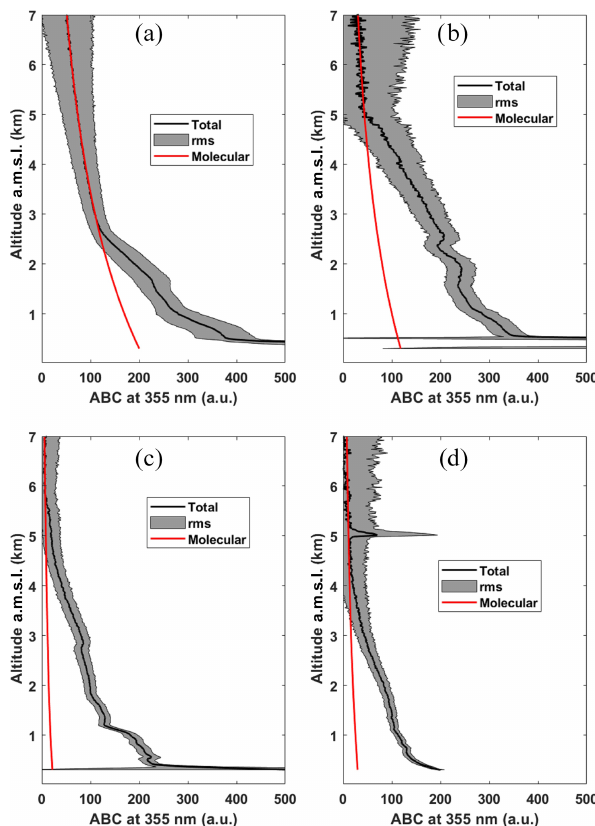
Figure A2. Apparent backscatter coefficient (solid black lines) pro- files obtained from the ALS lidar in Henties Bay on (a) 22 Au- gust 2017 between 14:00 and 23:00UTC, (b) 28 August 2017 be- tween 10:30 and 12:30UTC, (c) 7 September 2017 between 16:00 and 19:00UTC, and (d) 8 September 2017 between 13:00 and 15:00UTC. The red lines correspond to the molecular backscatter coefficient computed using ERA5 data. The grey area is the stan- dard deviation linked with the statistical error (the shoot noise and the atmospheric